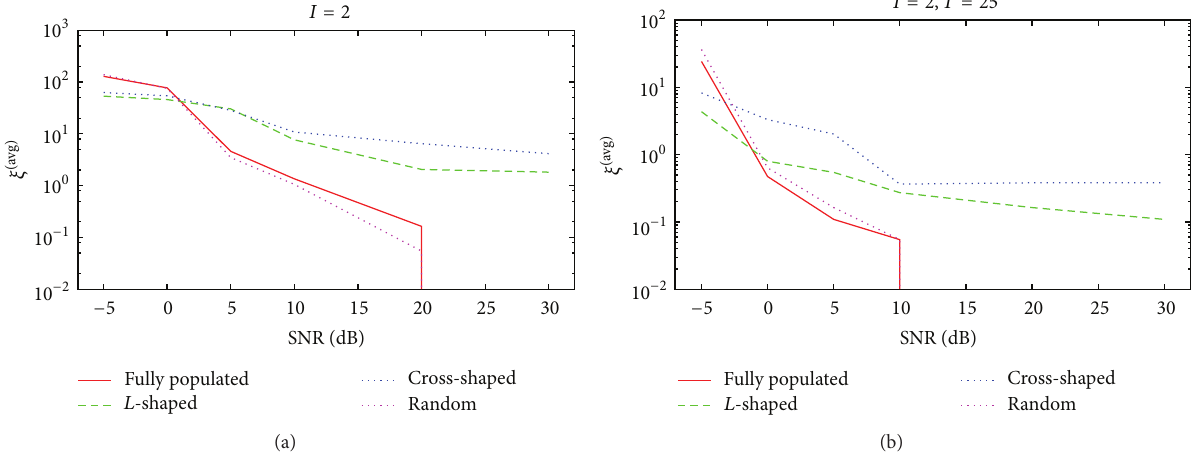
Figure 11: Array geometries comparison—( 𝑁 = {9, 25} ; 𝑑 𝑥 = 𝑑 𝑦 = 0.5𝜆 ; 𝐼 = 2 ; SNR = 10dB; 𝑇 = {1,25} ; 𝐶 = 50 )—behavior of the location index 𝜉 ( ave ) averaged among 𝐶 different noisy scenarios versustheSNR when using(a) theST-BCSwith 𝑇 = 1 snapshot and (b)theMT-BCS with 𝑇 = 25